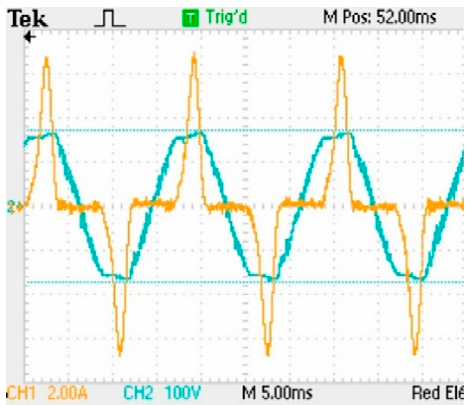
Figure 15. Waveforms of the current and voltage in oscilloscope for the non-linear load.